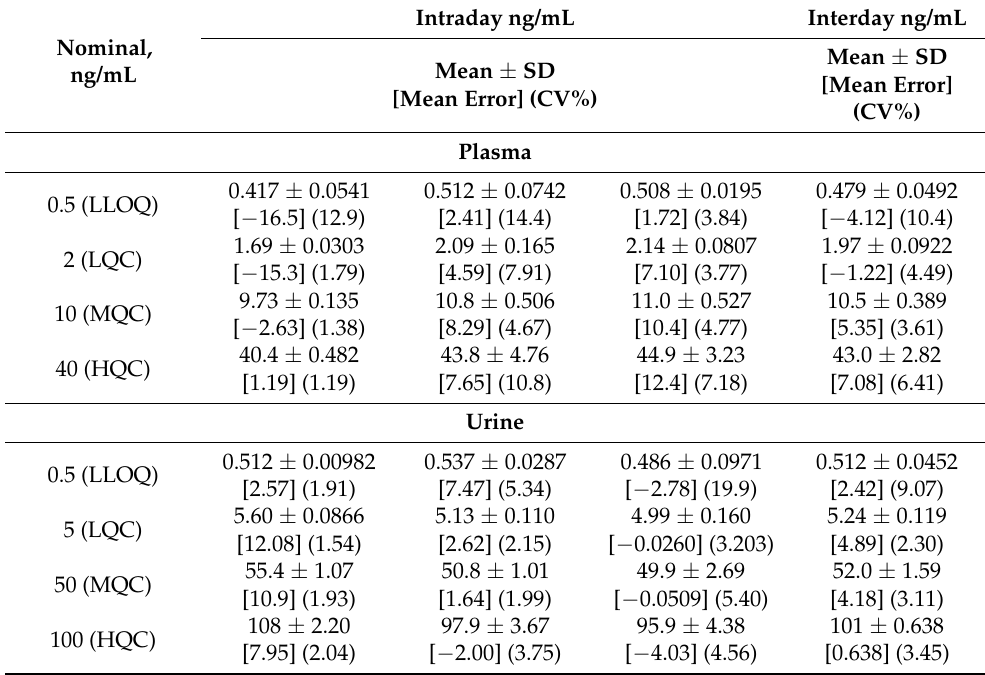
Figure 5. MRM ion-chromatograms of blank urine ( left panels ), 0.5 ng/mL colchicine ( middle panel ), and 32.0 ng/mL colchicine at 24 h after an intravenous dose (0.1 mg/kg; right panel ). The urine volume was 0.1 mL for each chromatogram. Table 1. Validation data for the assay of colchicine in 0.1 mL of rat plasma and urine ( n = 5 per